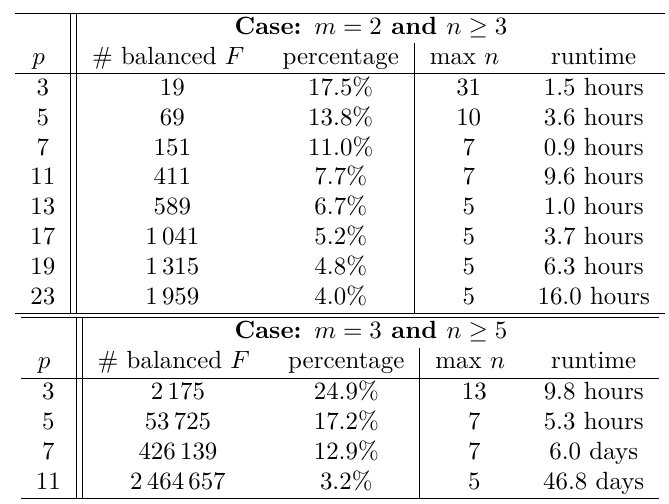
Table 3: Summary of our practical results for d = 2 and m ∈ { 2 , 3 } . For each p ≥ 3, we report the maximum value of n tested, the number of balanced quadratic functions with respect to the total number of functions F (with α total runtime in